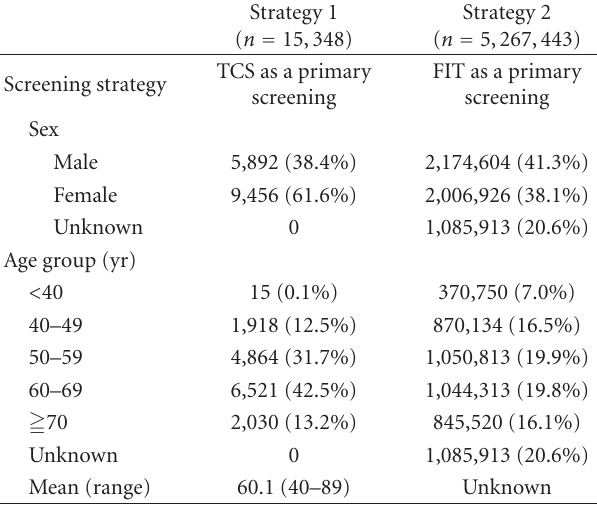
Table 1: Clinical characteristics of examinees in strategies 1 and